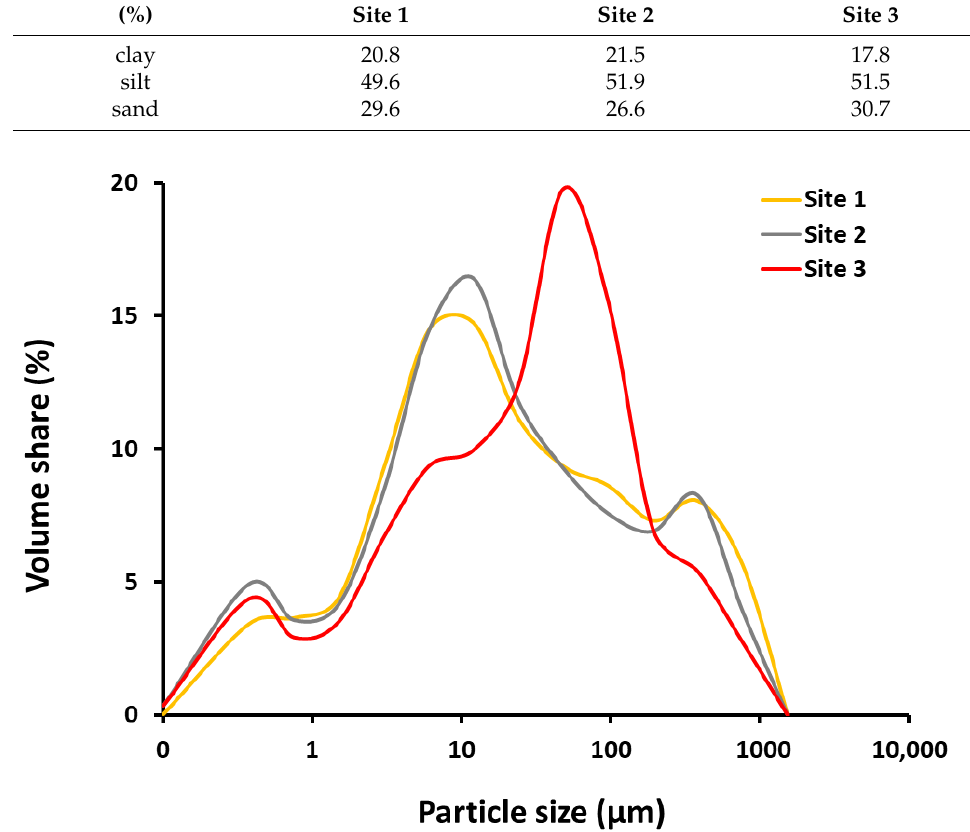
Table 1. Granulometric characteristics of sediment samples.